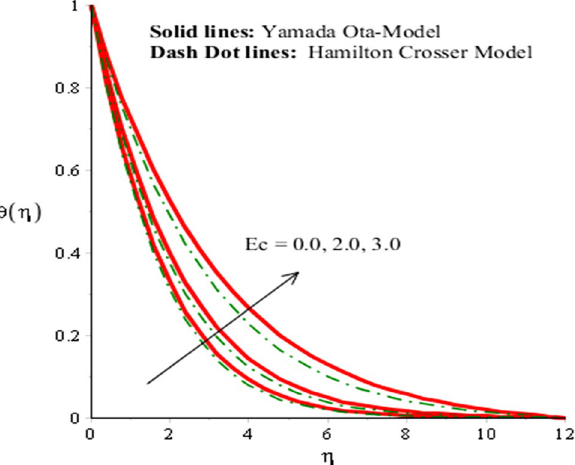
0.002, ∅ 2 = 0.0075, (cid:31) = 0.3, β e = 0.4,